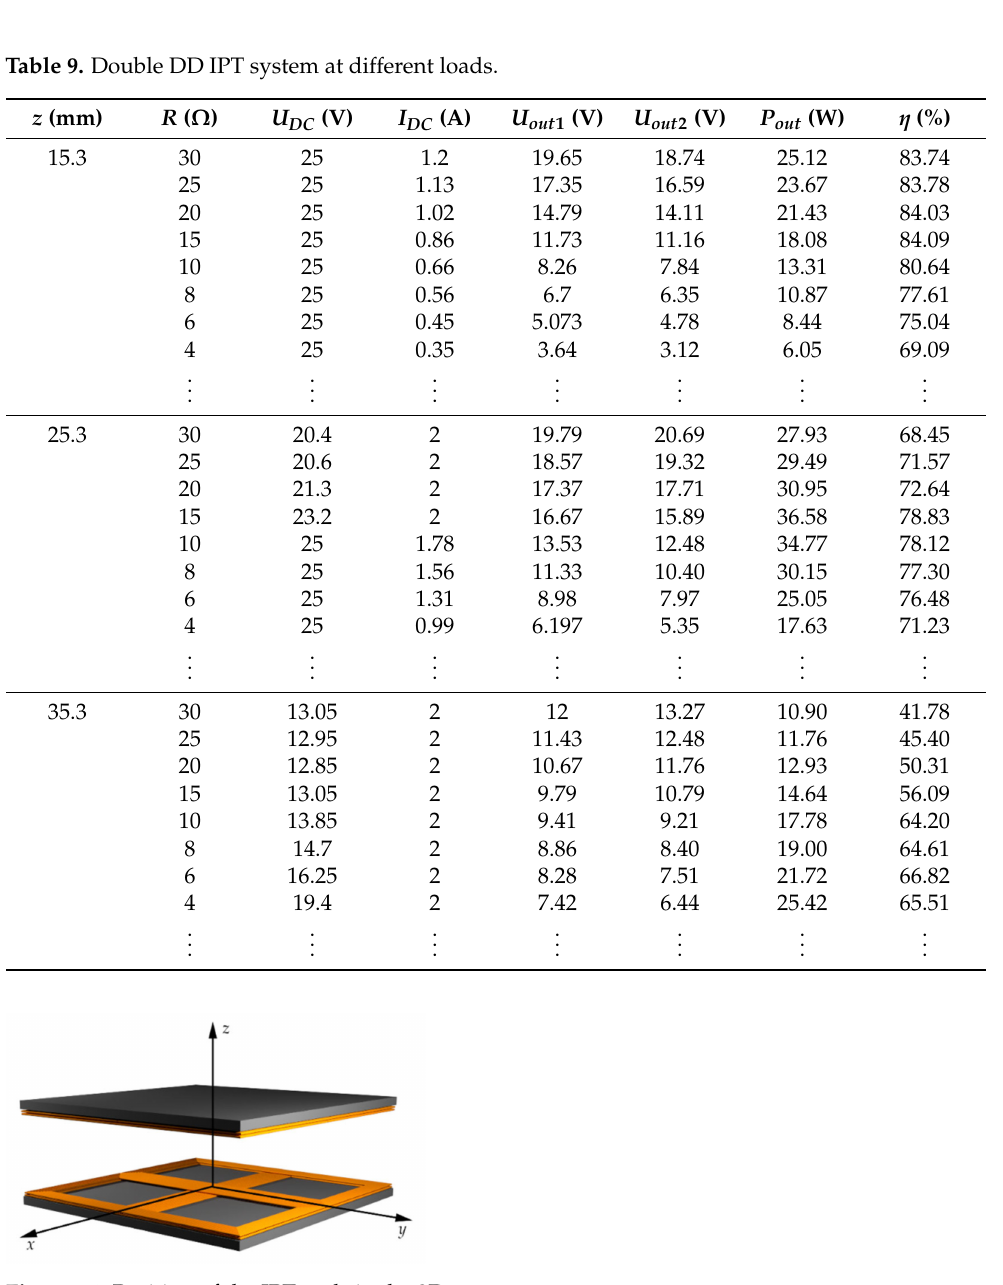
Figure 24. Position of the IPT pads in the 3D